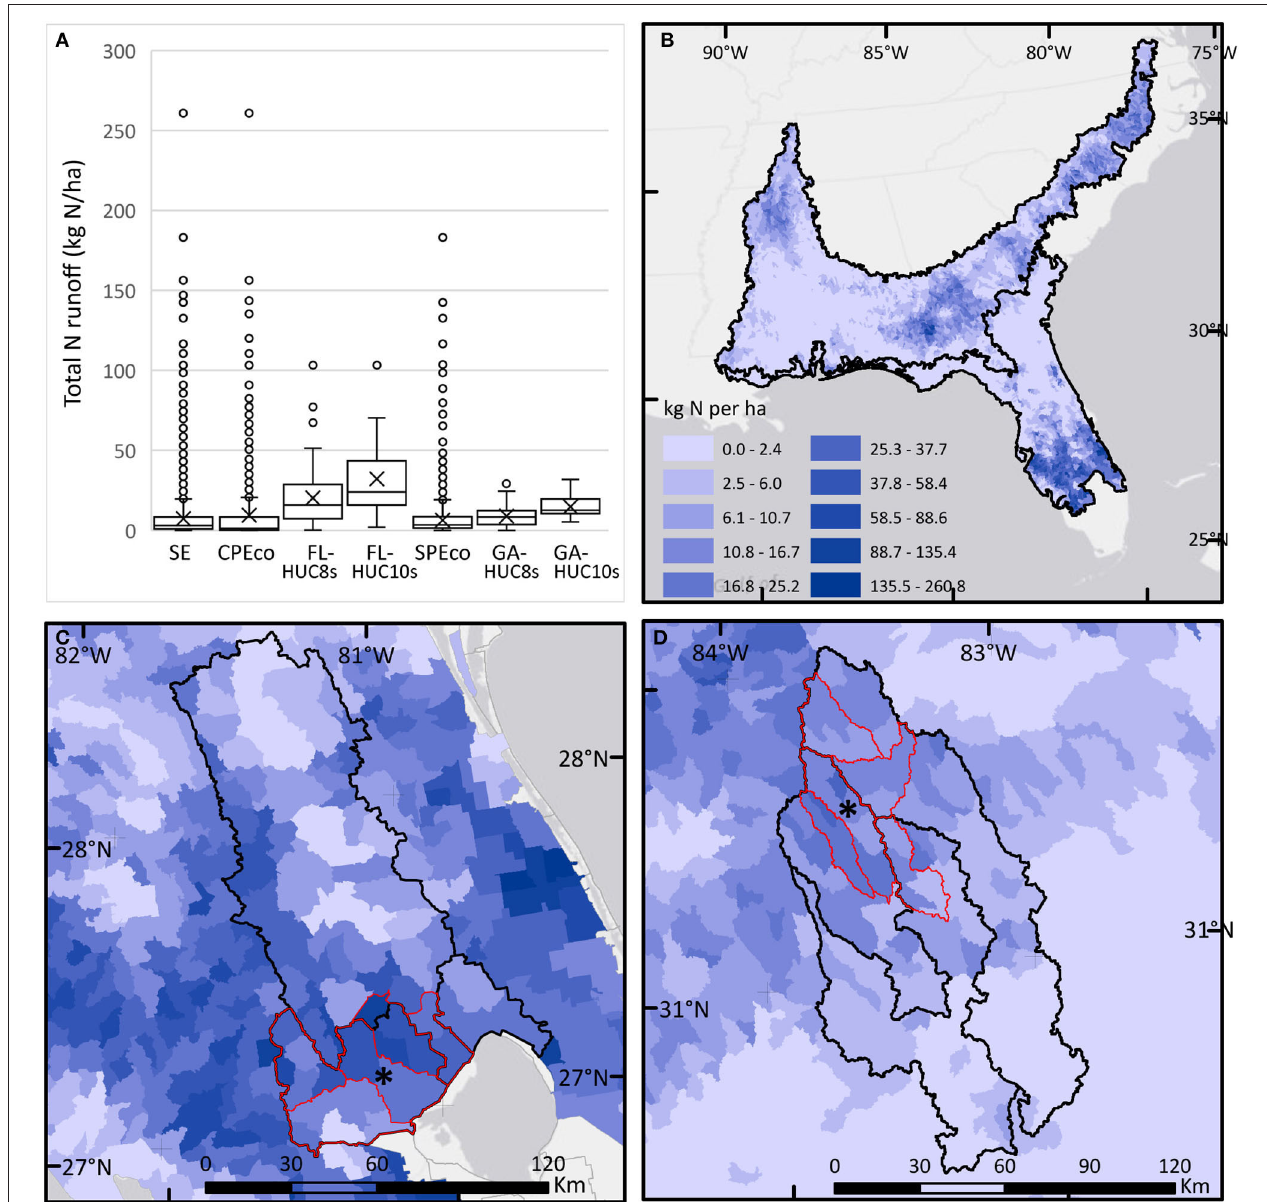
FIGURE 7 | Boxplots and maps of modeled agricultural nitrogen runoff (N, kg/ha) calculated for HUC-12 areas and summarized for each study area. (A) Boxplots of N for each study area. Asterisk (*) shows location of LTAR sites. (B) Map of N calculated for HUC-12s in the Southeast (SE). (C) Map of N calculated for HUC-12s in the Florida study areas. (D) Map of N calculated for HUC-12s in the Georgia study